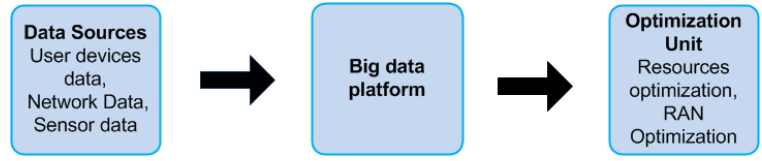
Figure 8. Big data aware networks layout (inspired from [58]).